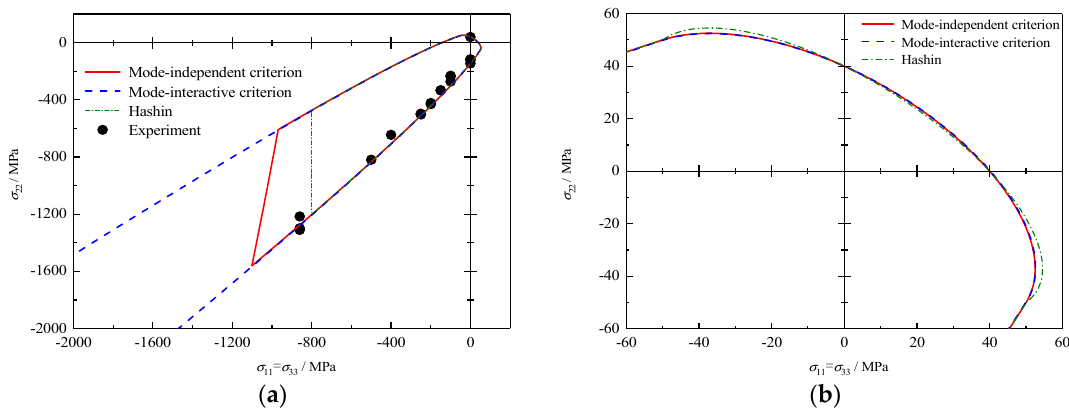
- σ σ (where = σ σ ) for E- 22 33 11 33